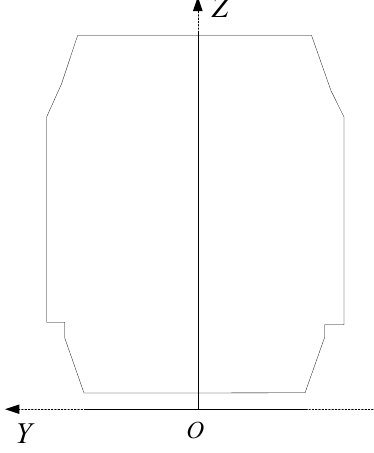
Figure 12. Unification of clearance test frame model and clearance coordinate system.